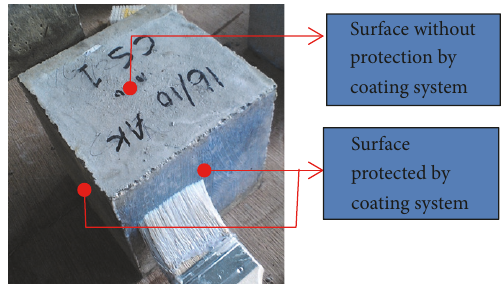
Figure 2: The process of surface treatment using coating system.